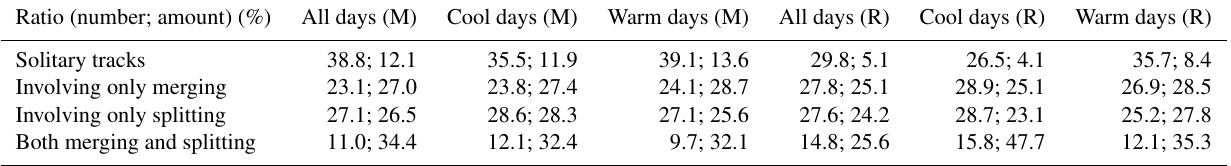
Figure 9. Mean diurnal cycles of the convective organization indices SCAI (a, e, i) , COP (b, f, j) , I org ( c , g , k ; color shading shows the range between percentiles 2.5 and 97.5 as described in Sect. 2.4), and I shape (d, h, l) , for all days (a–d) , for cool days (e–h) , and for warm days (i–l) , for the model simulation with 625m grid spacing and for RADOLAN. Averaging was carried out over all grid boxes where radar data are available. Table 2. Ratio of the number of tracks of given track types (solitary, tracks that involve only merging, tracks that involve only splitting and tracks involving both merging and splitting), and the total amount of rainfall that they contribute, relative to the total number and rainfall amount of all tracks. Tracks that touch the domain boundaries are removed from the analysis. Fractions (in percent), including all 36 model days, and conditioned on only the cold and the warm days, as defined in Table A1, are given for both the model simulation (M) and the RADOLAN composite